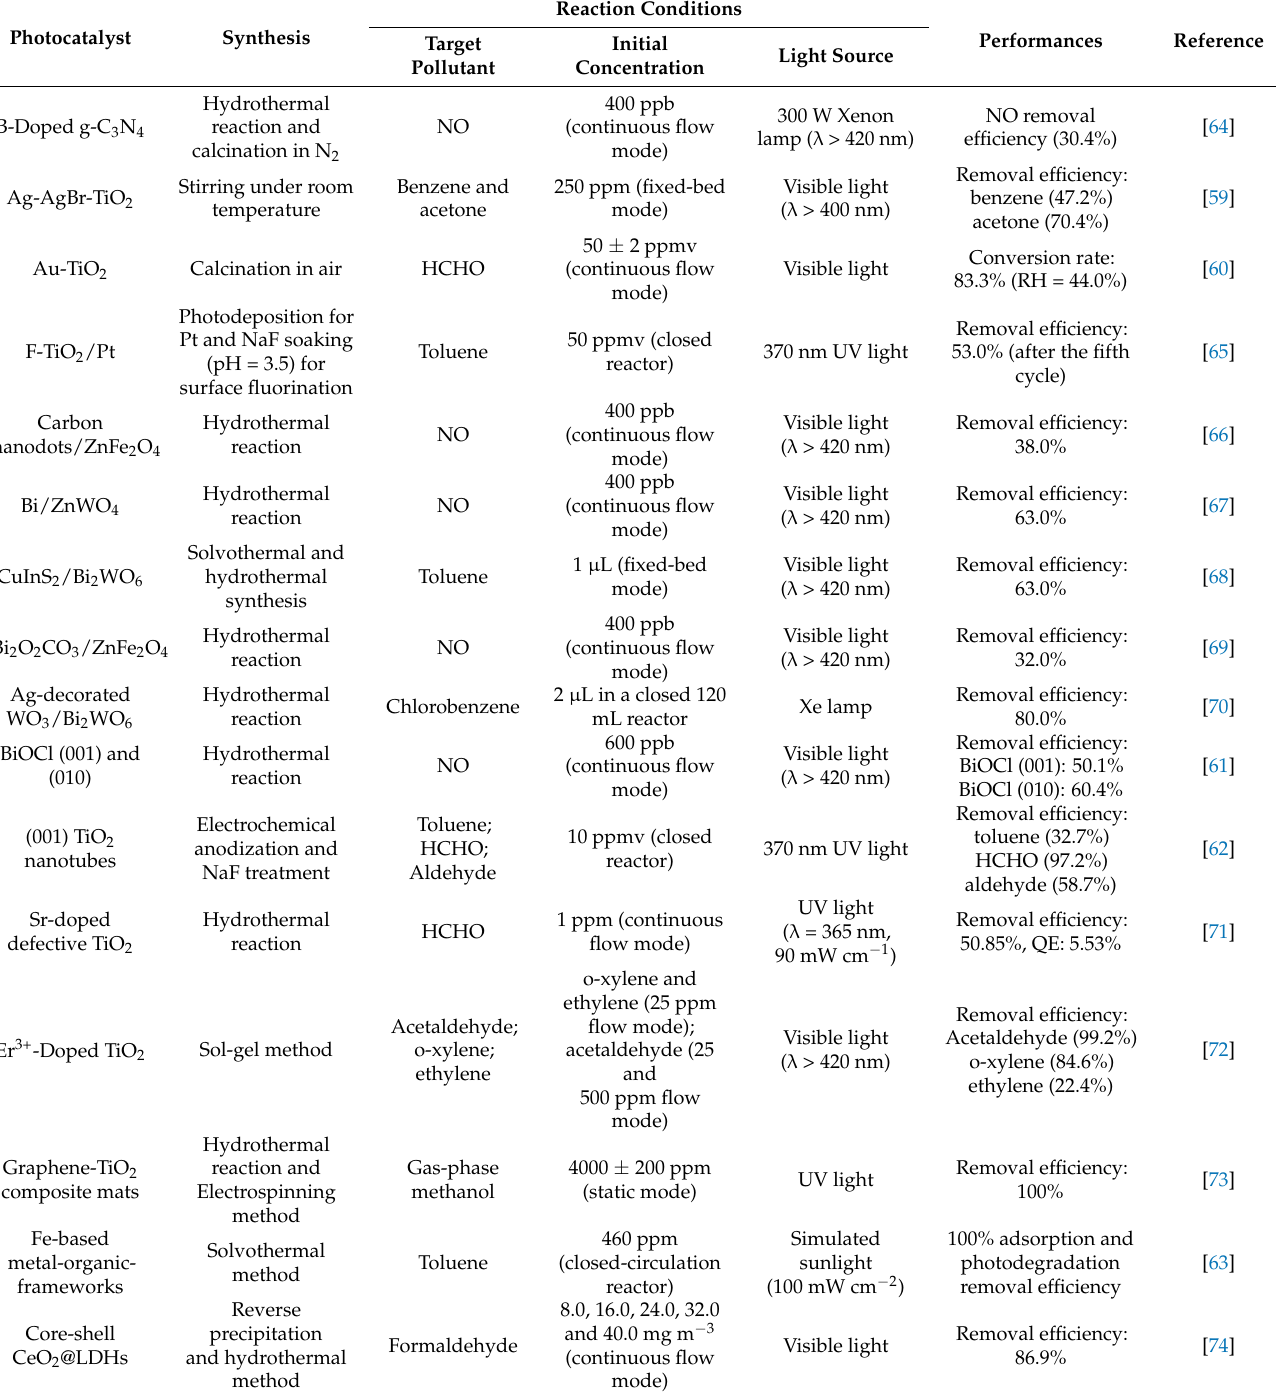
Table 2. Summary of typical nanomaterials used for gaseous pollutant